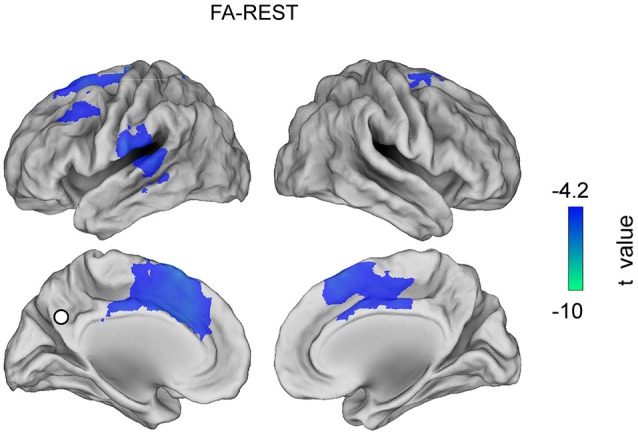
T map for the contrast FA meditation vs. REST obtained in the alpha band (p < 0.01, FDR corrected value).